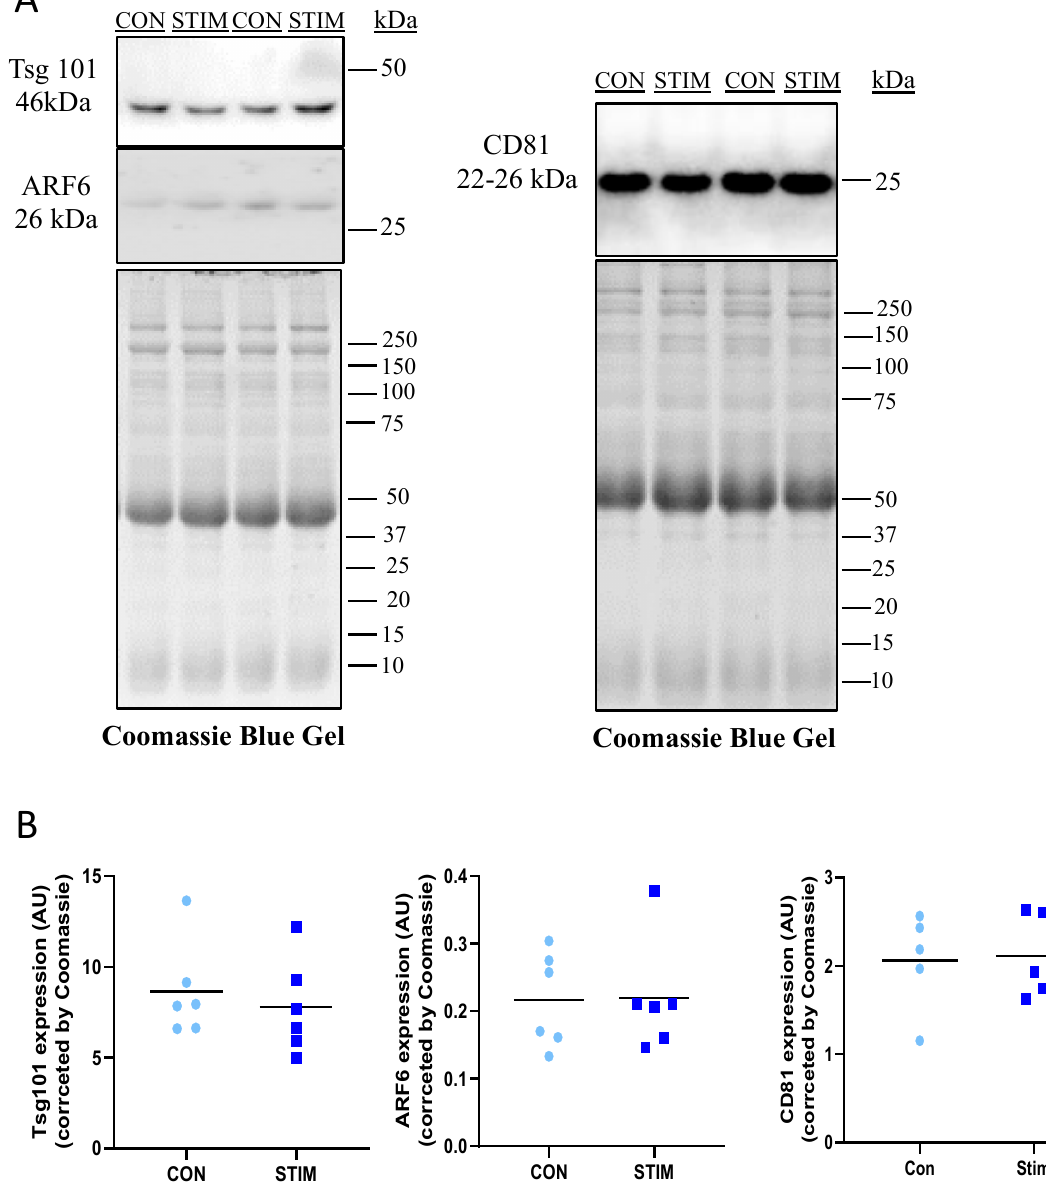
Figure 5. Effect of acute stimulation on expression of EV subtype protein markers. Equal amounts (50 µg) of non-stimulated control (CON) vs. acutely stimulated (STIM) myotube-EP lysates were subjected to 12% SDS–PAGE. EPs were isolated using Total Exosome Isolation Reagent (ThermoFisher, Waltham, MA, USA). Coomassie blue-stained gels were used as a loading control. ( A ) Representative immunoblots and ( B ) quantification of data shows no difference in the expression of exosomal markers CD81 and TSG101, nor in the content of microvesicle marker ARF6 in EPs lysates CON vs. STIM myotubes ( n = 5–6). Data were analyzed using an unpaired Student’s t test and are expressed as scatter plots with mean.